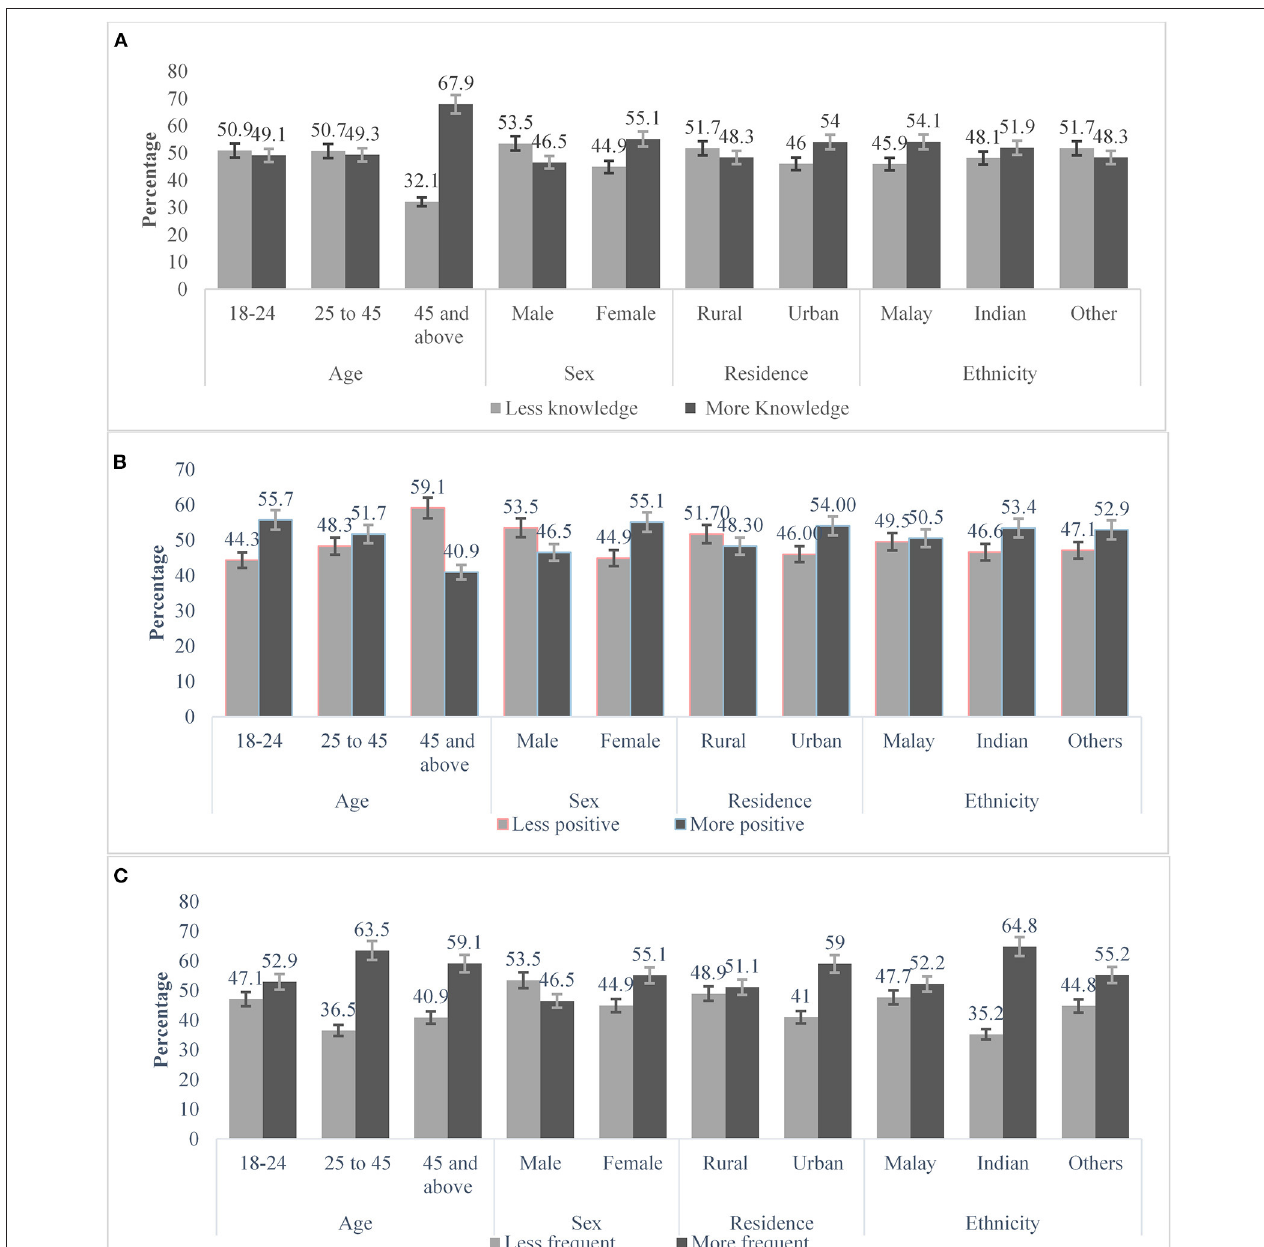
FIGURE 3 | Respondent’s knowledge (A) , attitude (B) and practice (C) patterns toward COVID-19. The vertical axis represents percentage and parallel axis are the respondent’s age, sex, residence and ethnicity.